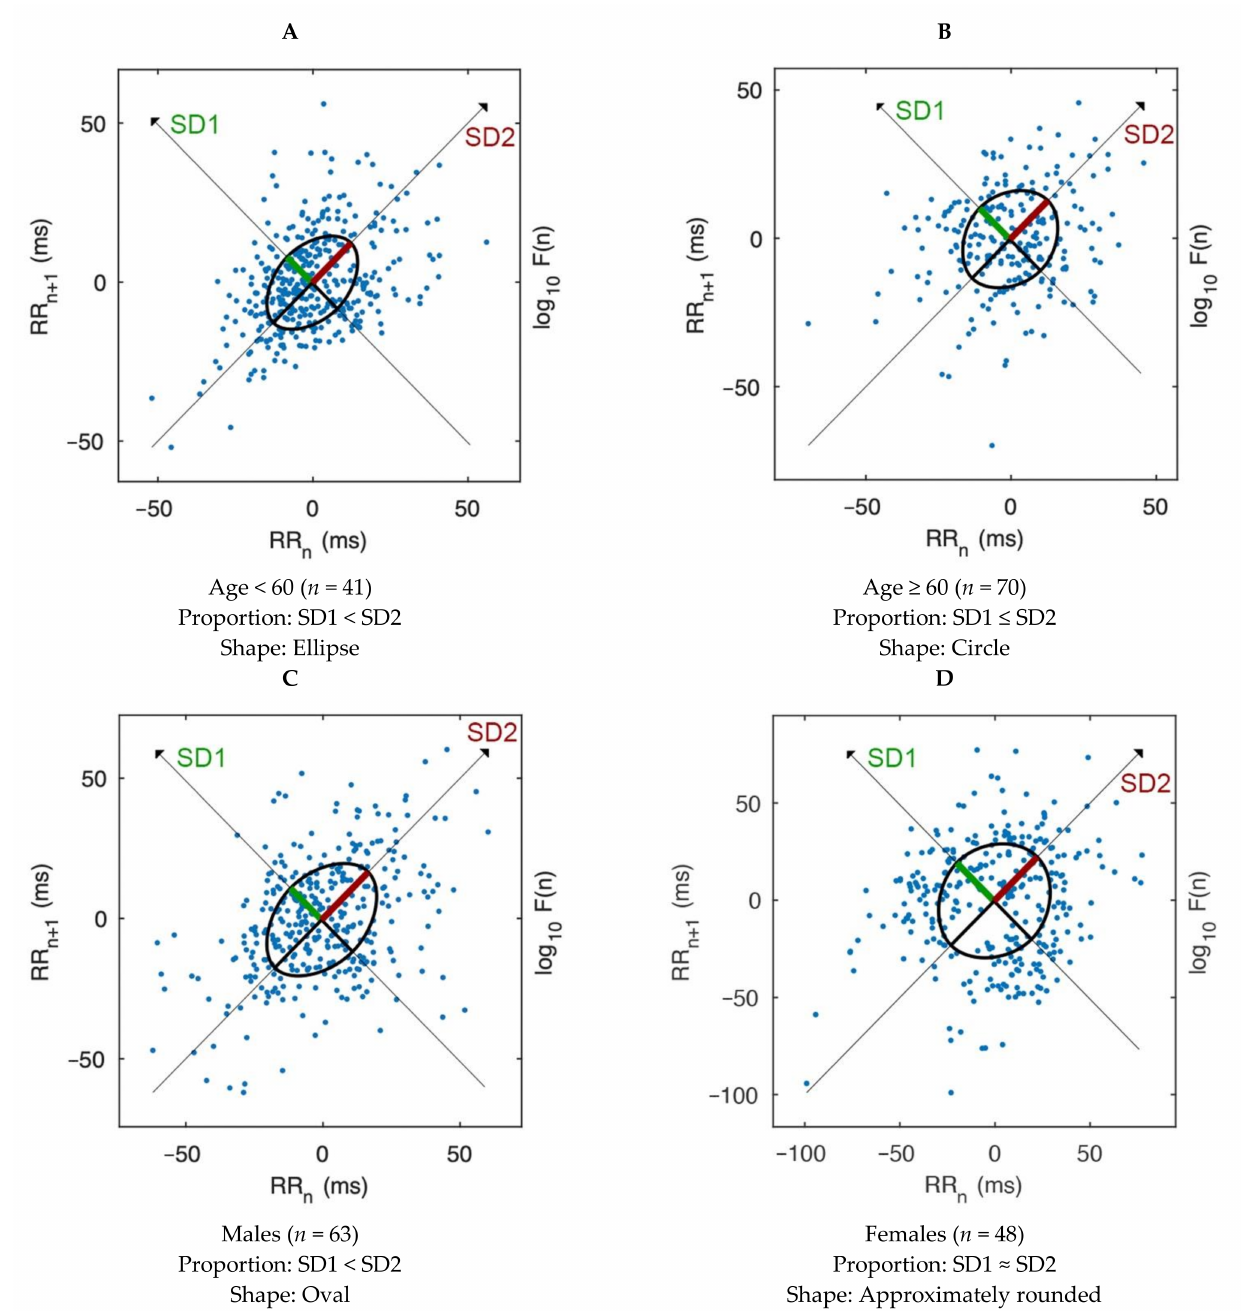
Figure 2. Comparison of Poincar é plots in all ischemic stroke patients by age and sex. Poincar é plots of patients under 60 years old ( A ). Poincar é plots of patients over 60 years old ( B ). Poincar é plots of male patients ( C ). Poincar é plots of female patients ( D ). Note: Poincar é plots were presented as representative of each